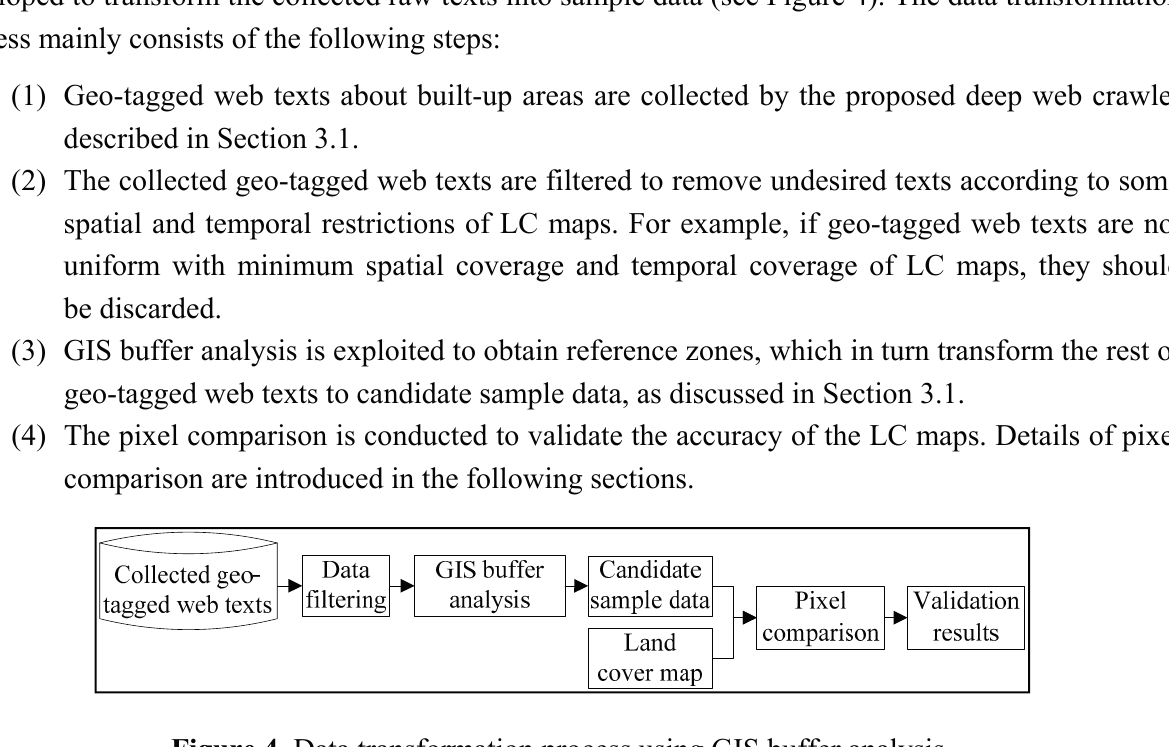
Figure 4. Data transformation process using GIS buffer